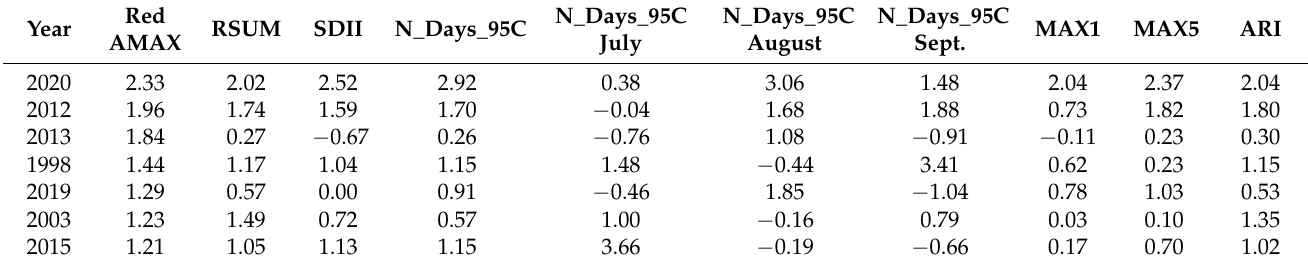
Table 13. Anomalies of red AMAX and extreme rainfall indexes for years with red AMAX anomaly >1 st.dev (sorted by Red